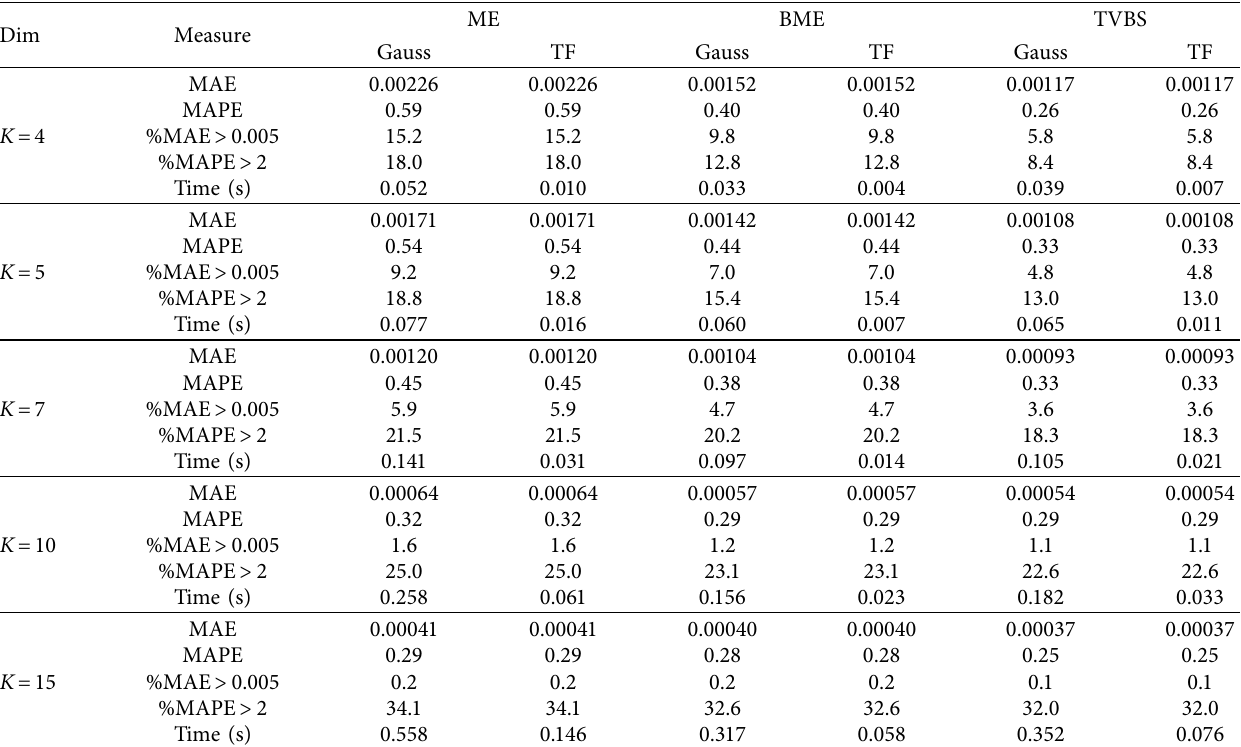
Table 2: MVNCD evaluation results for the different analytic approximation methods.